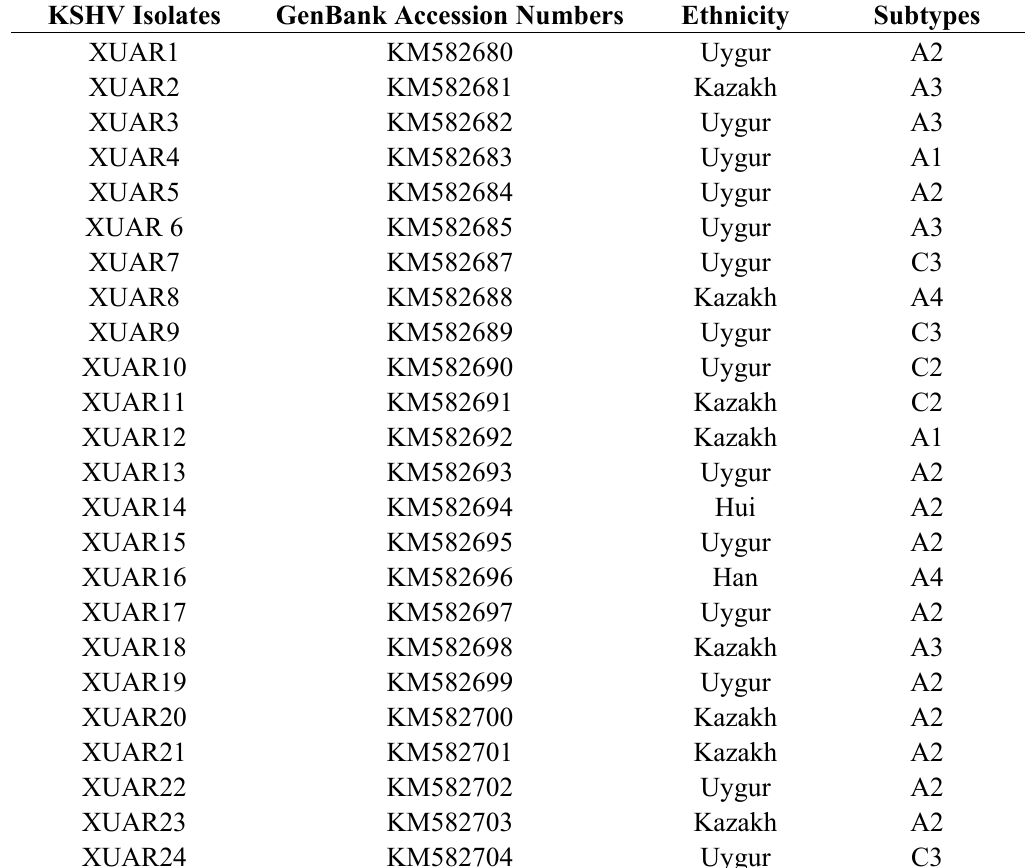
Table 3. KSHV K1 genotypes in different ethnic